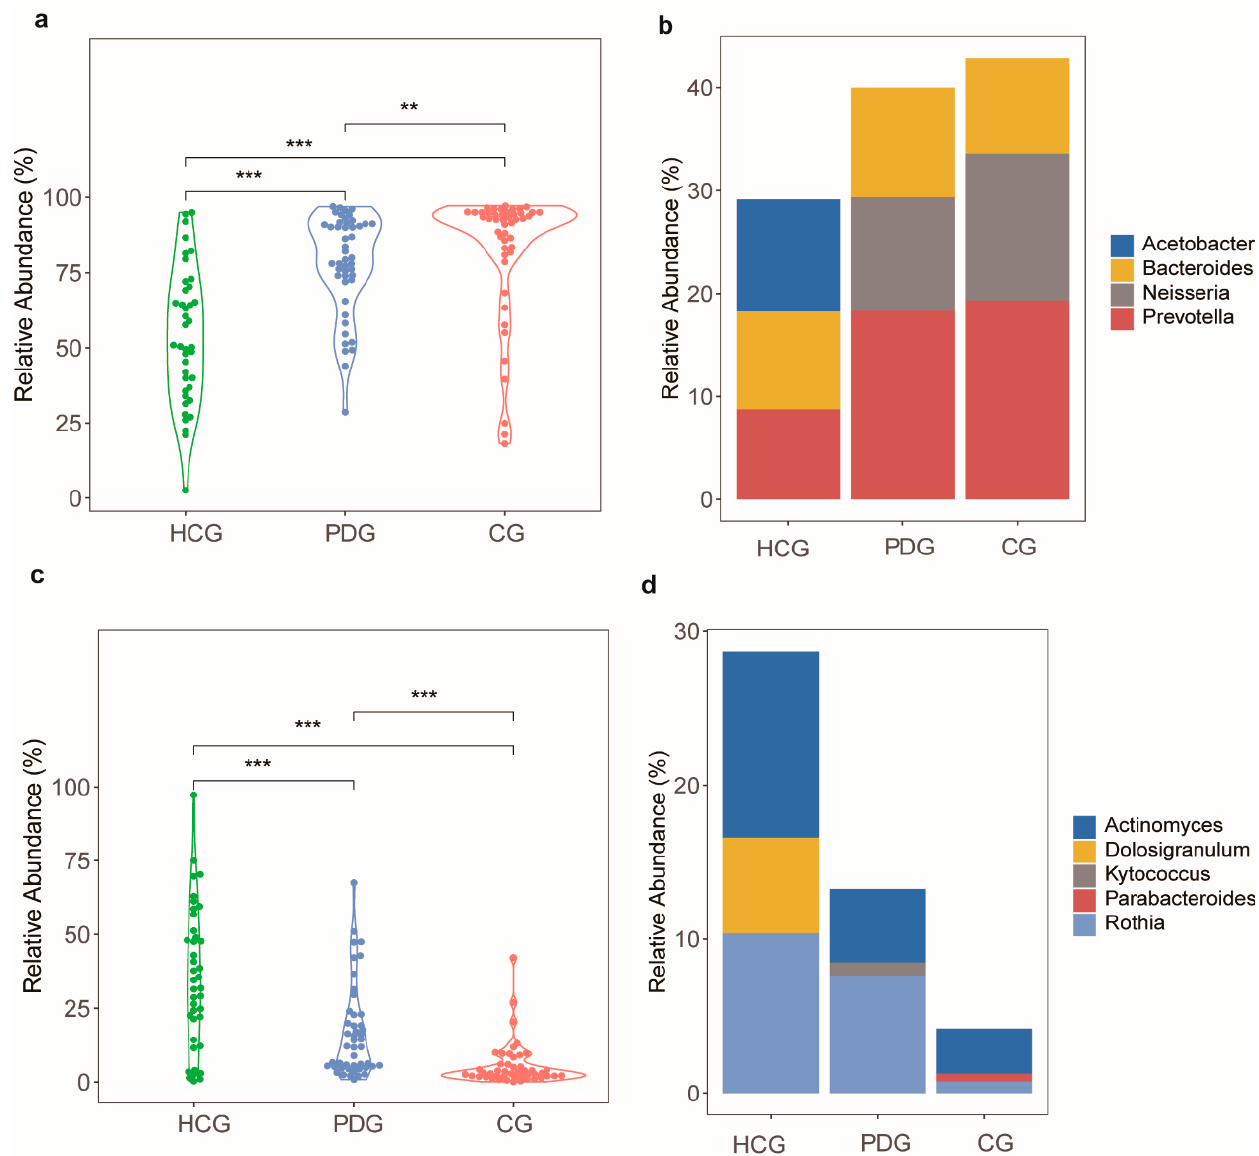
Figure 5. Alterations in Gram-negative and Gram-positive bacteria among HCG, PDG, and CG. ( a ) The relative abundances of Gram-negative bacteria in PDG and in CG were significantly greater than that in HCG, ( b ) and the major bacterium contributing to this was Prevotella. ( c ) The relative abundance of Gram-positive bacteria in PDG and in CG was significantly smaller than that in HCG, ( d ) and the major bacteria contributing to this were Rothia and Actinomyces. The p -values were con- firmed by the Wilcoxon rank-sum test. HCG: healthy control group. PDG: period of disease group. CG: convalescent group. P -values of < 0.05*, < 0.01**, and < 0.001*** were considered statistically sig- nificant.